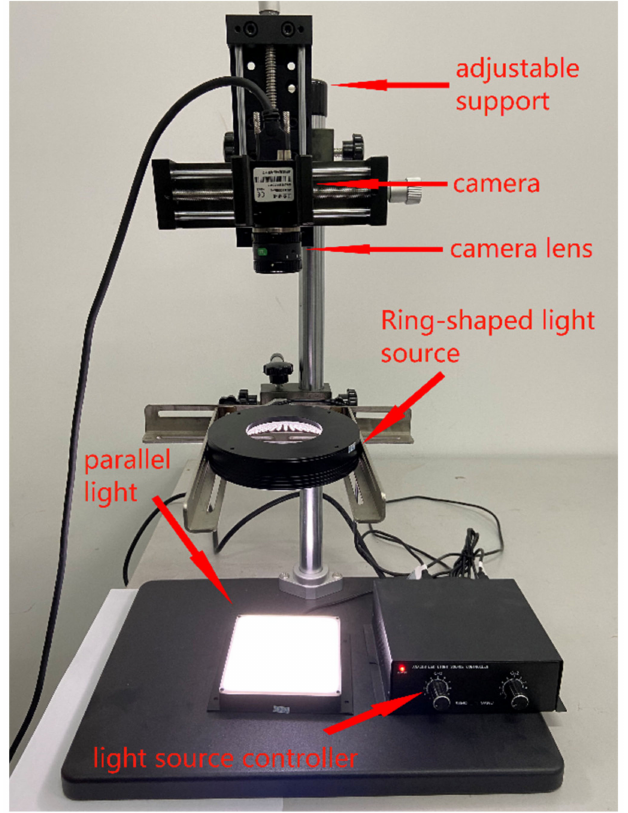
Figure 1. Physical structure of image acquisition